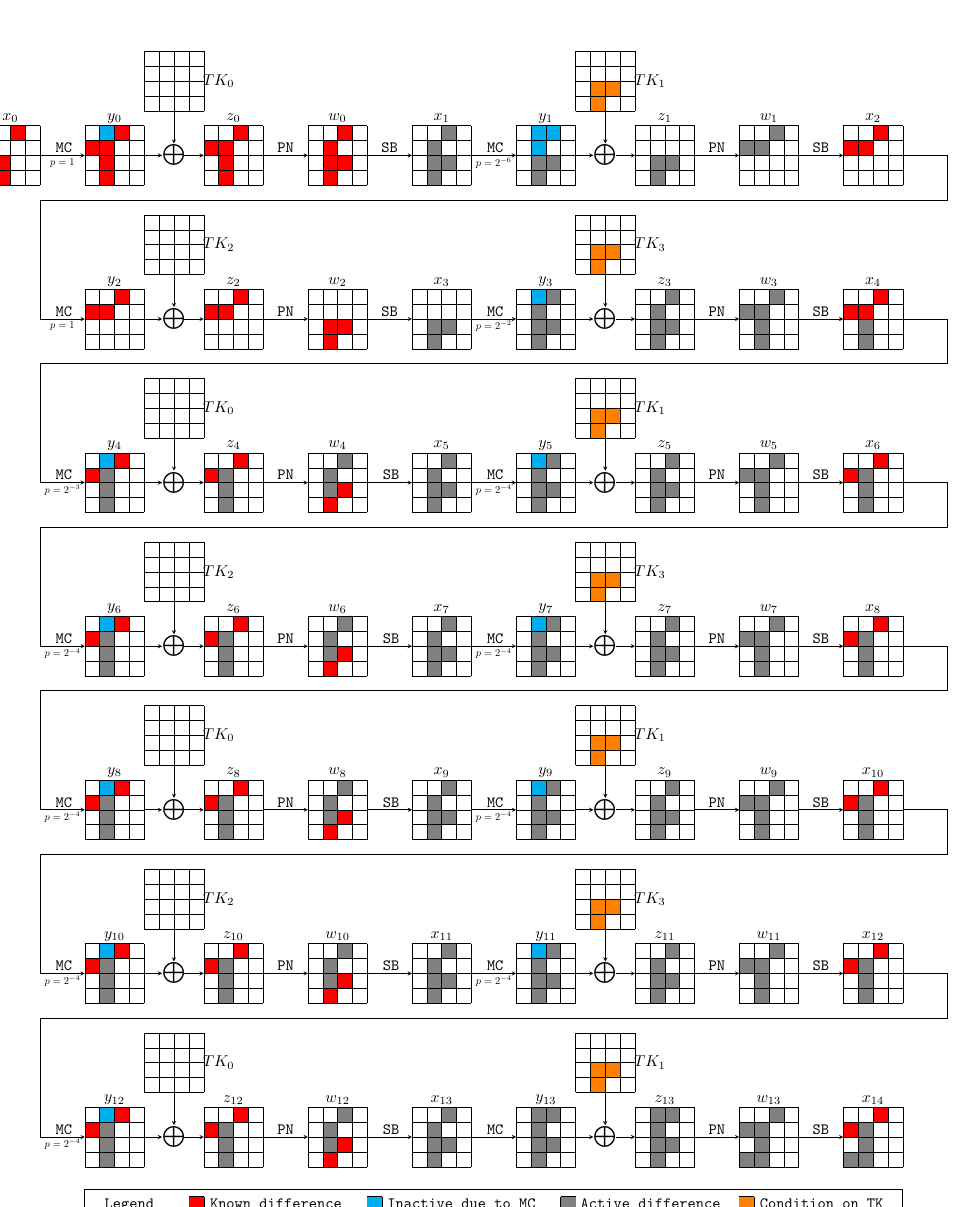
Figure 7: A 14-round truncated differential trail of CRAFT with probability 2 −